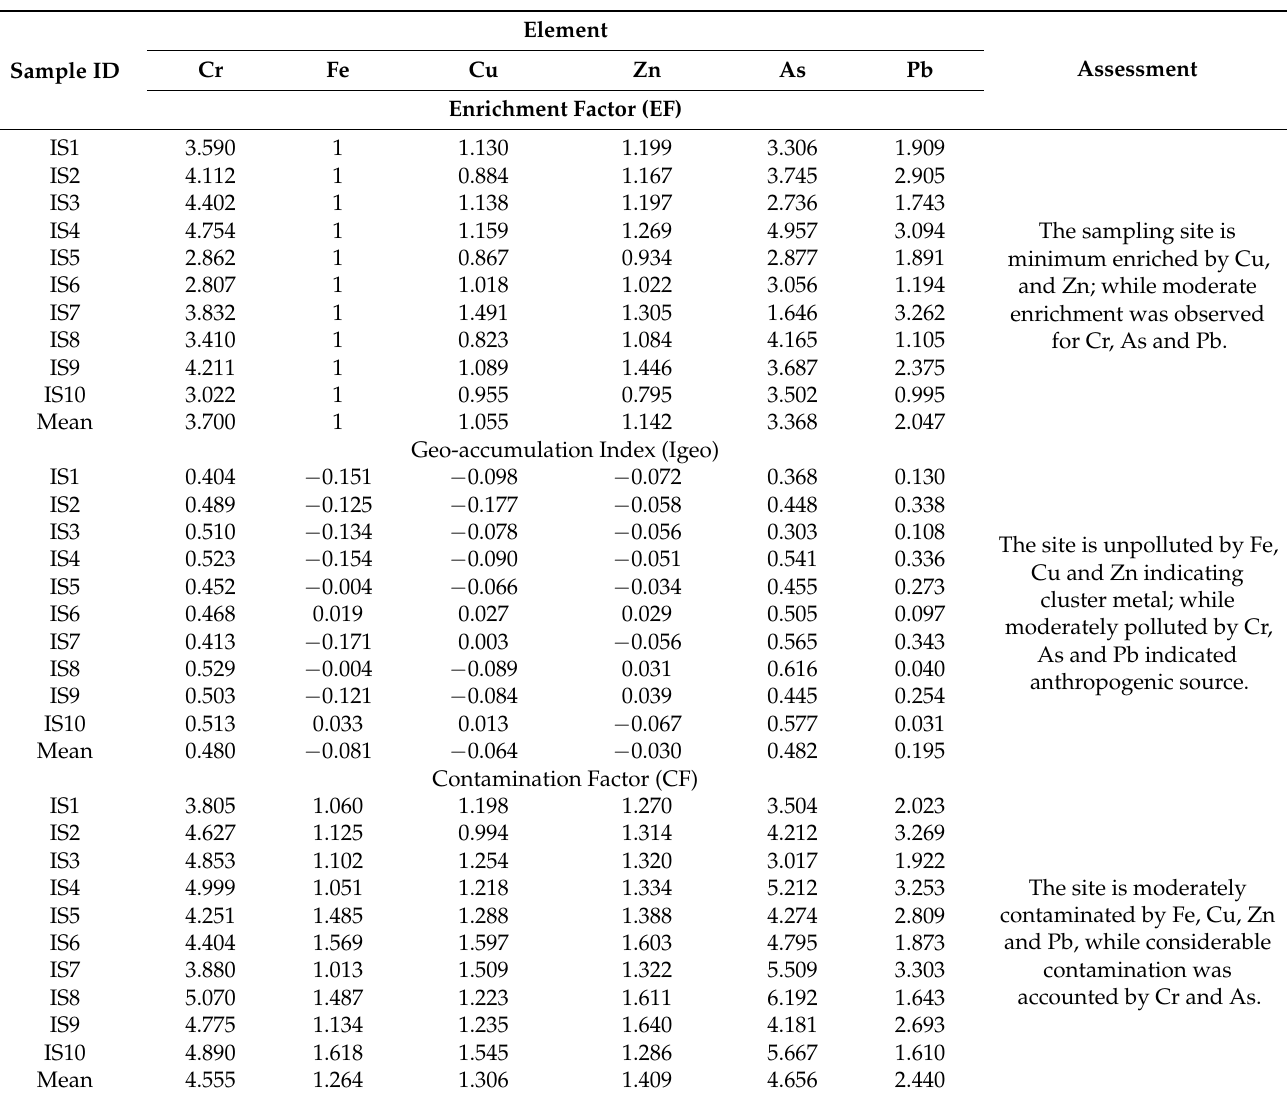
Table 4. Assessment of degree of pollution by the heavy metal in soil